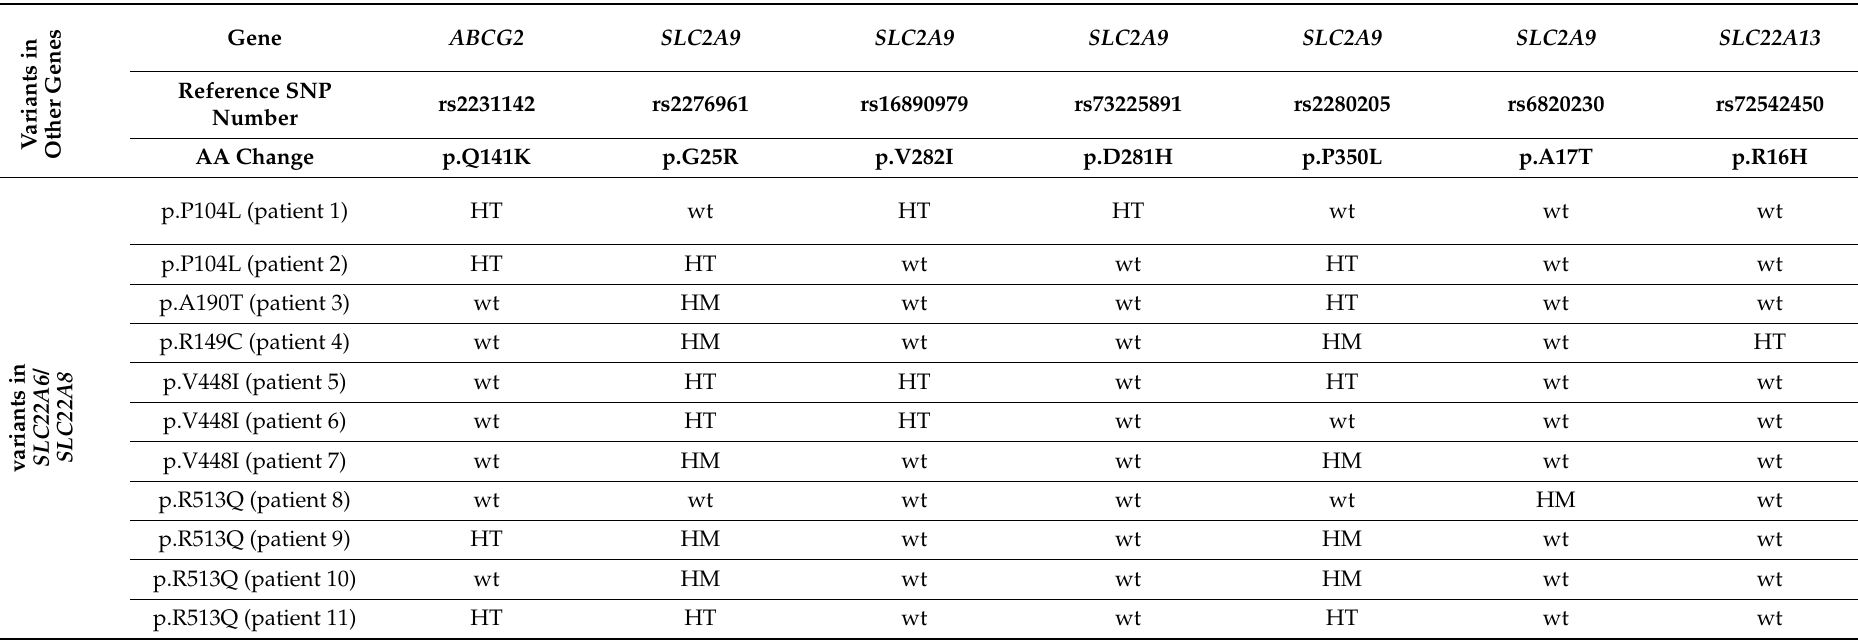
Table 5. Overview of genetic variants in other genes encoding urate transporters in patients with non-synonymous allelic variants in the SLC22A6 and